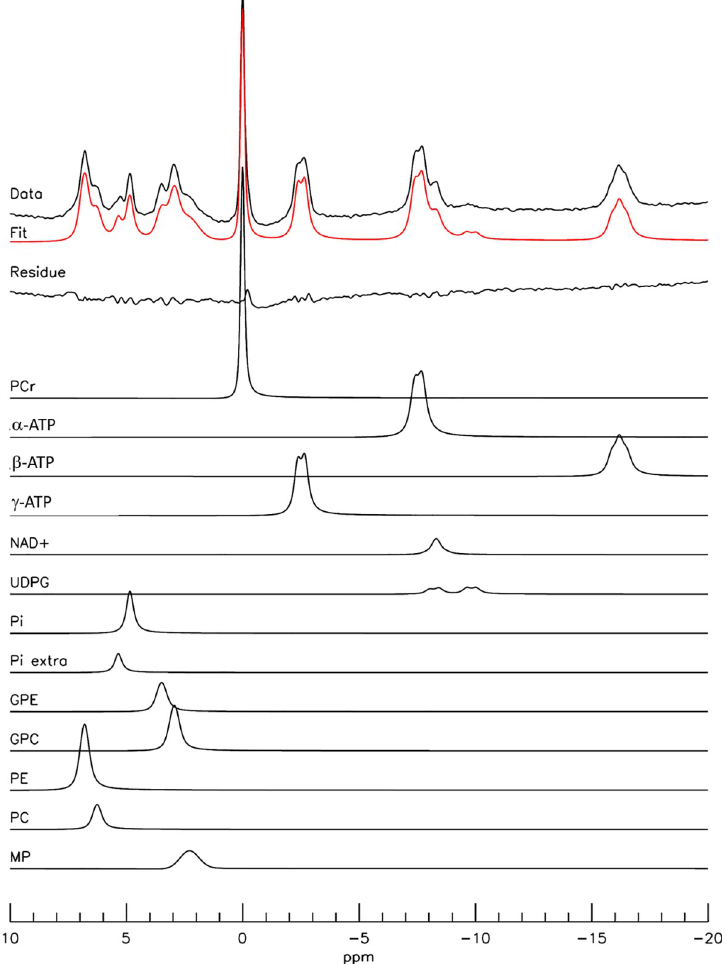
Fig 5. jMRUI analysis of a typical 31 P spectrum acquired at 3 Tesla. The original spectrum was from Fig 4B with TR = 25 seconds, NA = 64. The individual spectral components, the overall fit and fit residual were also shown. A Gaussian curve with freely adjustable linewidth was used to fit the MP signal at 2.3 ppm. PCr: phosphocreatine; α -, β -, γ -ATP: α -, β -, γ —adenosine triphosphate; NAD + : oxidized nicotinamide adenine dinucleotide; UDPG: uridine diphosphate glucose; Pi: inorganic phosphate; Pi extra: extracellular inorganic phosphate; GPE: glycerophosphosethanolamine; GPC: glycerophosphocholine; PE: phosphoethanolamine; PC: phosphocholine; MP: membrane